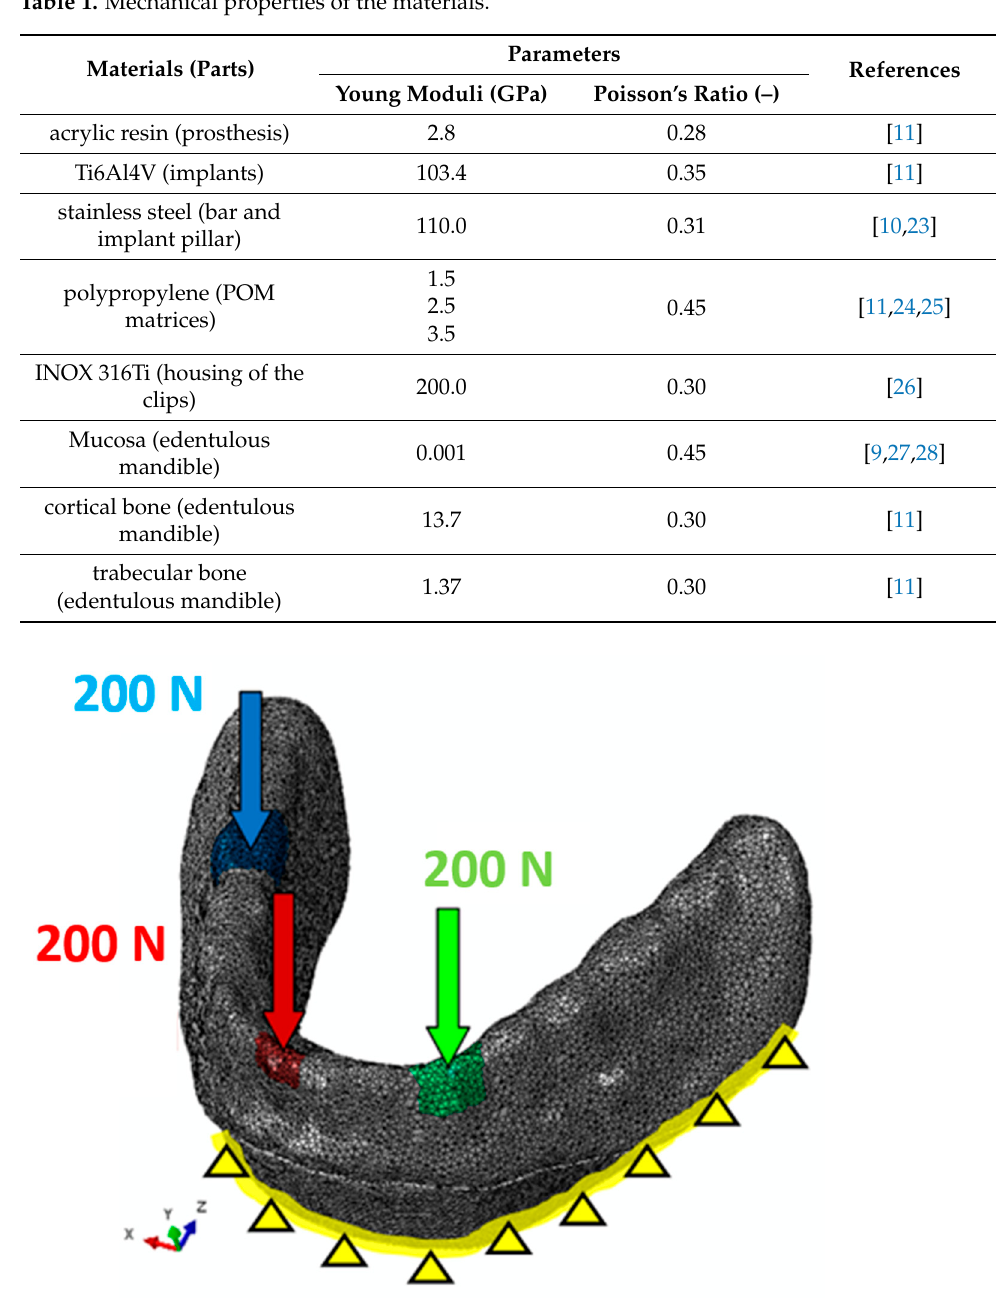
Figure 6. Finite element method model, three load cases, and boundary conditions.